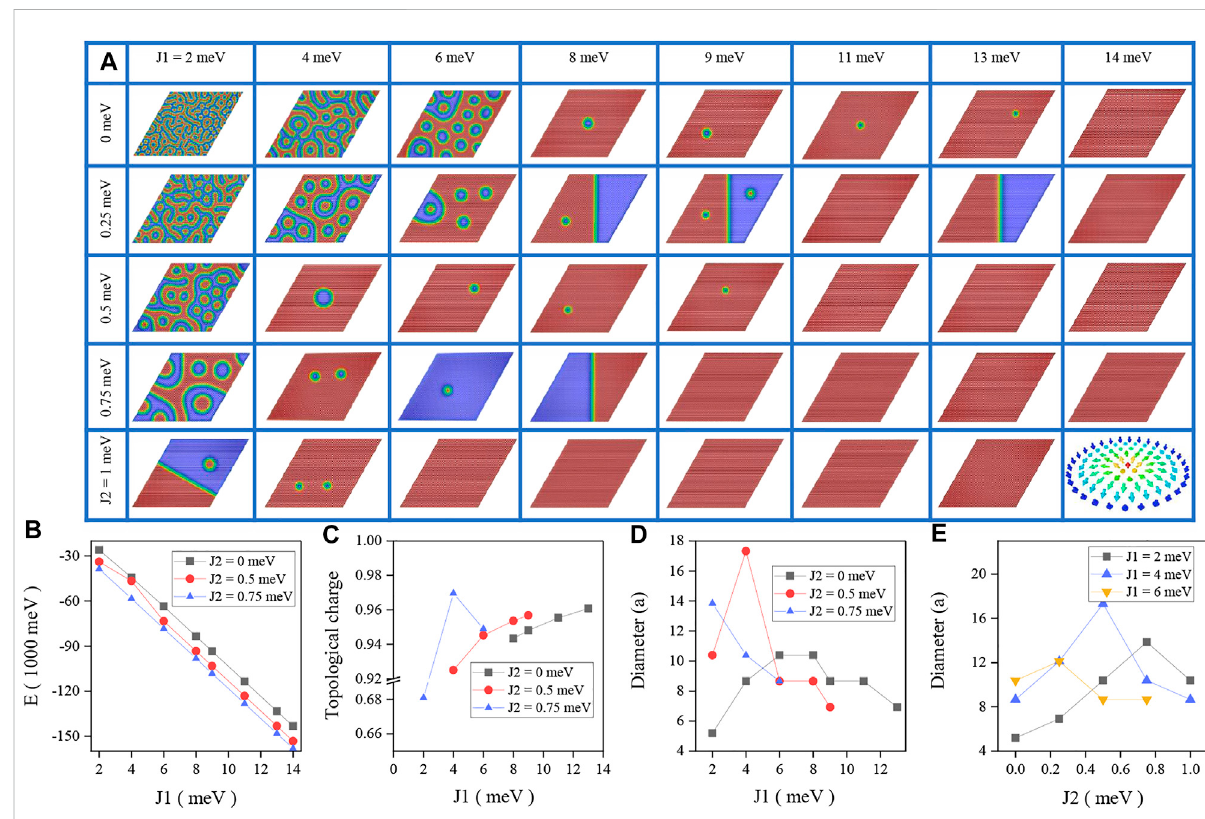
FIGURE 2 (A) Pro fi le of the magnetization of the fi nal state for different J 1 and J 2 in the presence of perpendicular magnetic anisotropy. (B) Total energy, (C) topological charge, and the skyrmion size (in unit of lattice constant a) as a function of (D) the fi rst-nearest-neighbor ferromagnetic exchange interaction J 1 and (E) the next-nearest-neighbor ferromagnetic exchange interaction J 2 . A skyrmion sketched by arrows denotes the magnetization